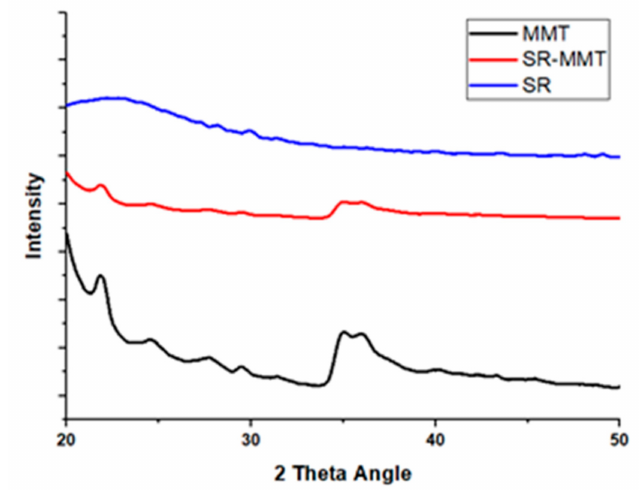
Figure 4. XRD pattern of pure SR, MMT powder and SR4 composition.